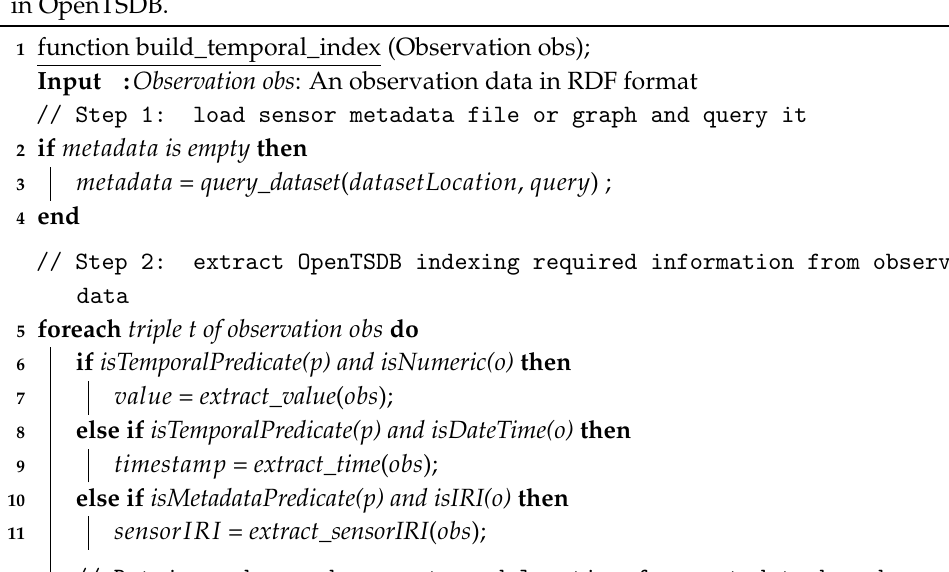
Algorithm 3: A procedure that will read an observation data and index its temporal information in OpenTSDB.